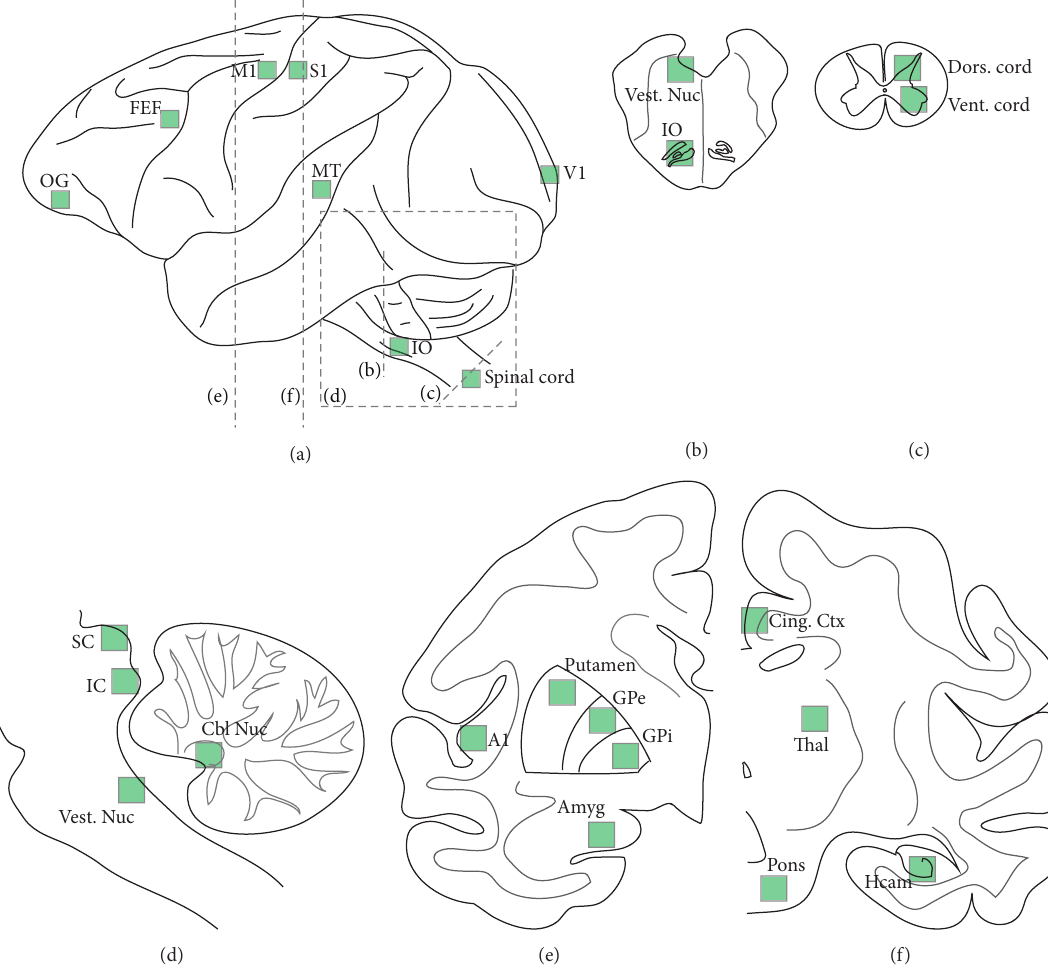
Figure 1: CNS of areas we examined for PNNs. (a) shows the left side of a monkey’s whole brain. The green squares show the approximate size and position of our tissue samples. The dashed lines represent planes for the other subfigures. We took samples from the orbital gyrus (OG), the frontal eye field (FEF), primary motor cortex (M1), primary somatosensory cortex (S1), primary visual cortex (V1), and mediotemporal cortex (MT), the inferior olive (IO), and the cervical spinal cord. (b) shows the brainstem locations of our samples from the inferior olive (IO) and the vestibular nuclei. (c) shows the spinal cord where we sampled both the dorsal and ventral horns. (d) shows a sagittal representation of the brainstem and cerebellum where we took samples from the superior colliculus (SC), the inferior colliculus (IC), the cerebellar nuclei (Cbl Nuc), and the vestibular nuclei. (e) shows the left half of the brain in a frontal plane where we took samples from primary auditory cortex (A1), the putamen, the external globus pallidus (GPe), the internal globus pallidus (GPi), and the amygdala (Amyg). (f) shows the right half of the brain in a frontal plane where we took samples from the pontine nuclei, the hippocampus (Hcam), the thalamus (Thal), and cingulate cortex (Cing.